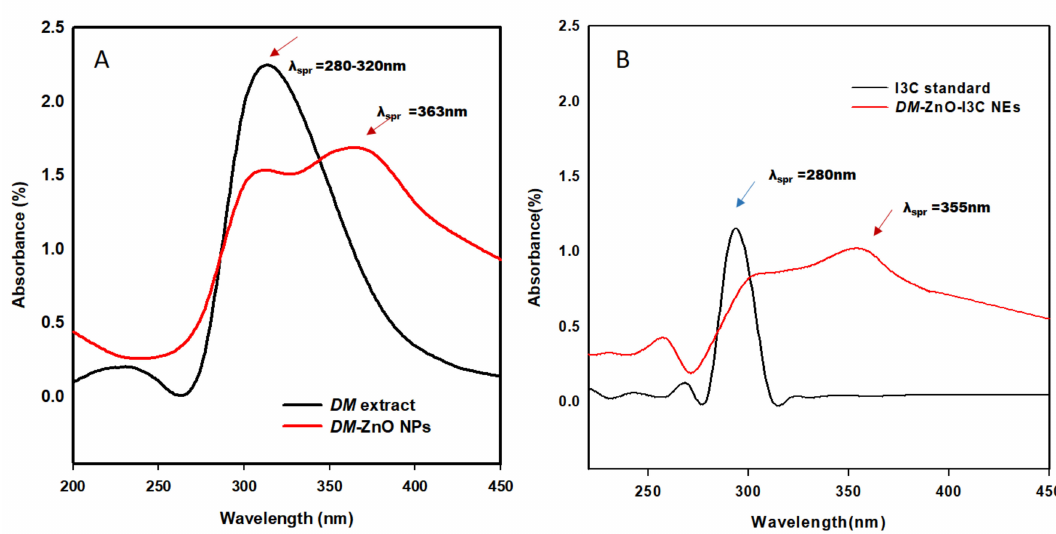
Figure 2. UV-Visible spectra of ( A ) Dendropanax morbifera zinc oxide nanoparticles ( DM -ZnO NPs) with DM extract, ( B ) DM -ZnO-I3C-NE with standard